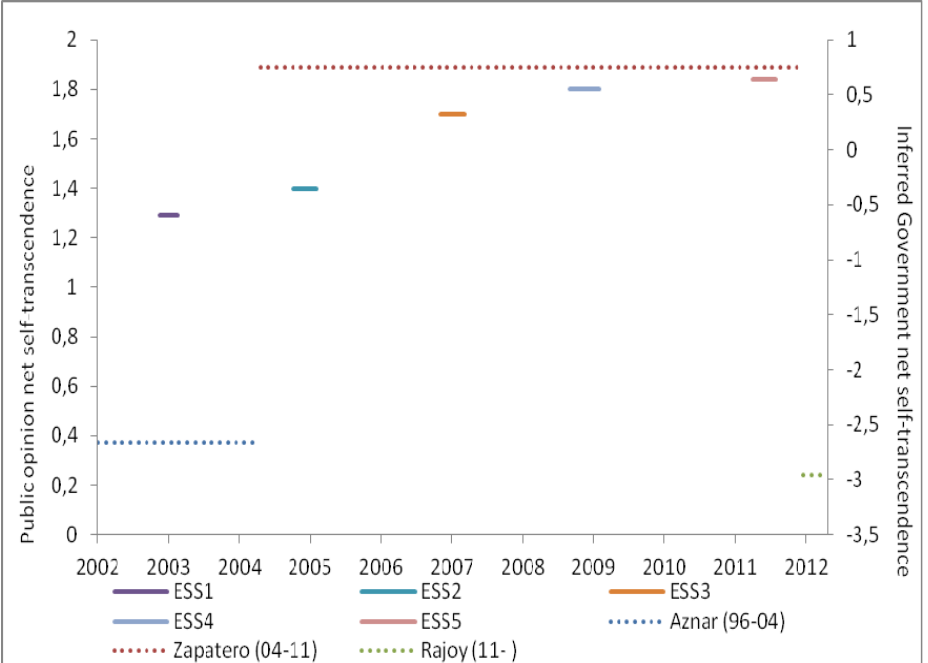
Figure 4: Net self-transcendence for